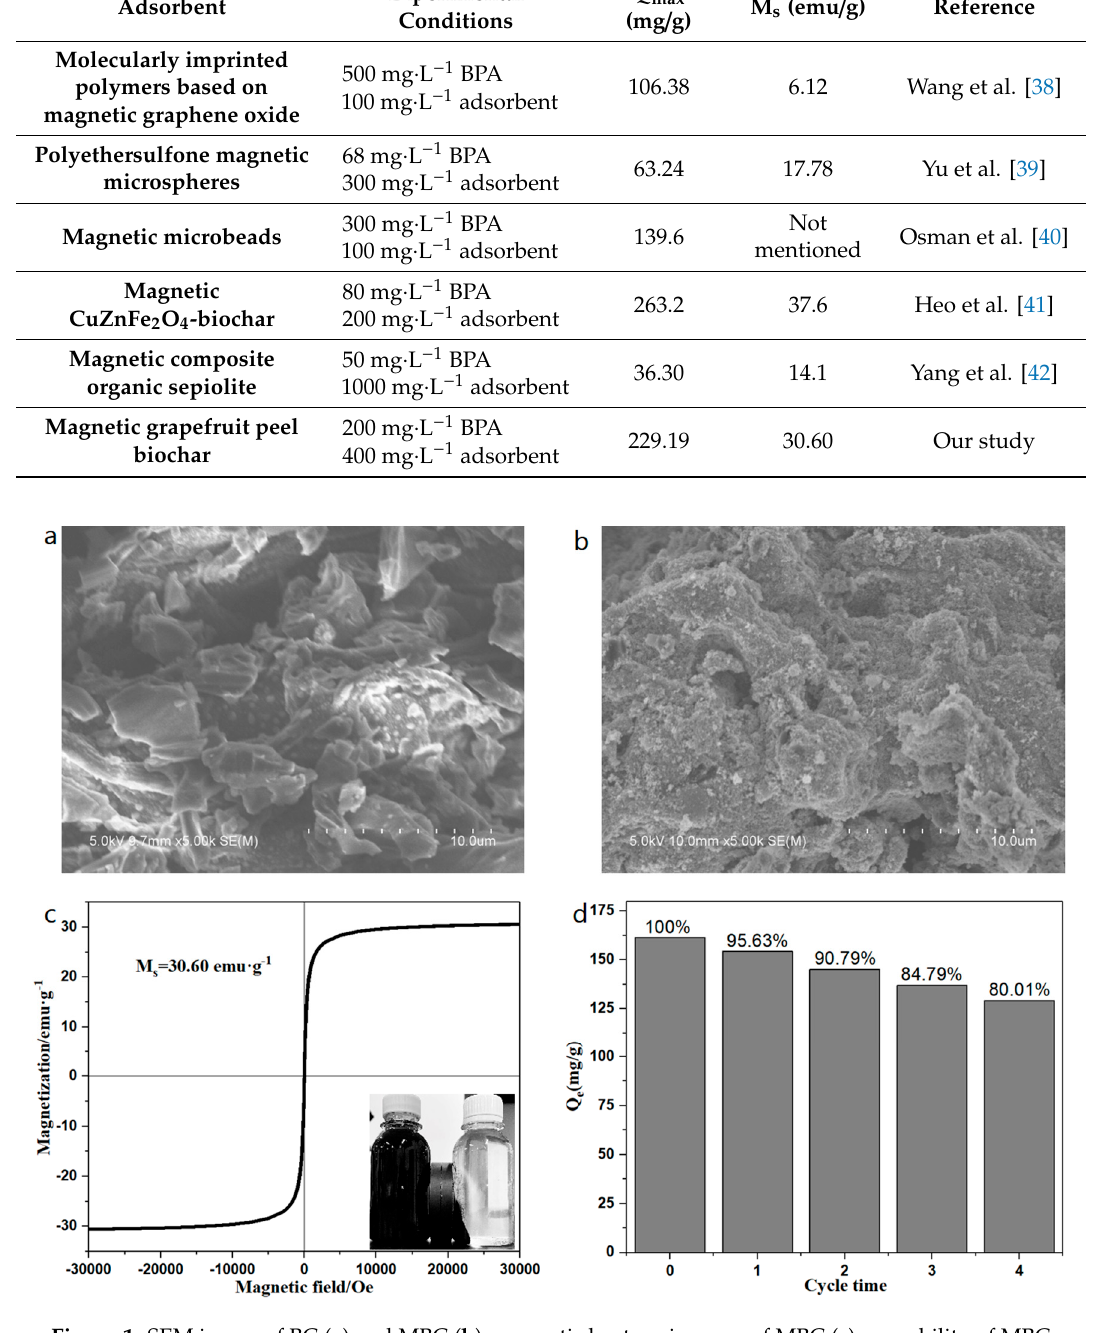
Figure 1. SEM image of BC ( a ) and MBC ( b ), magnetic hysteresis curve of MBC ( c ), reusability of MBC for BPA removal ( d ).